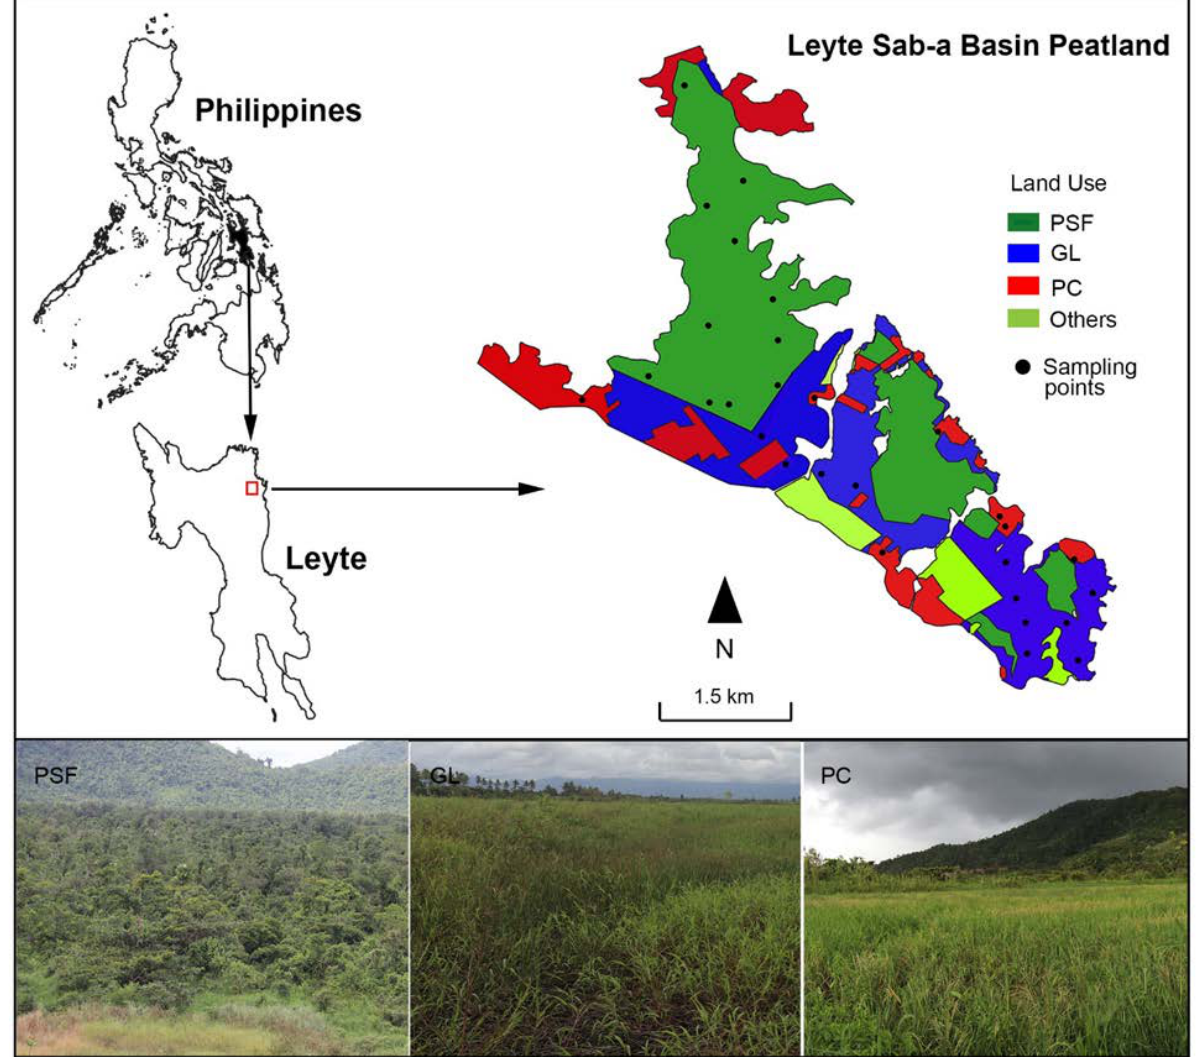
Figure 1. Map of the Leyte Sab-a Basin Peatland, locations of sampling points and land use. PSF=peat swamp forest, GL=grassland,